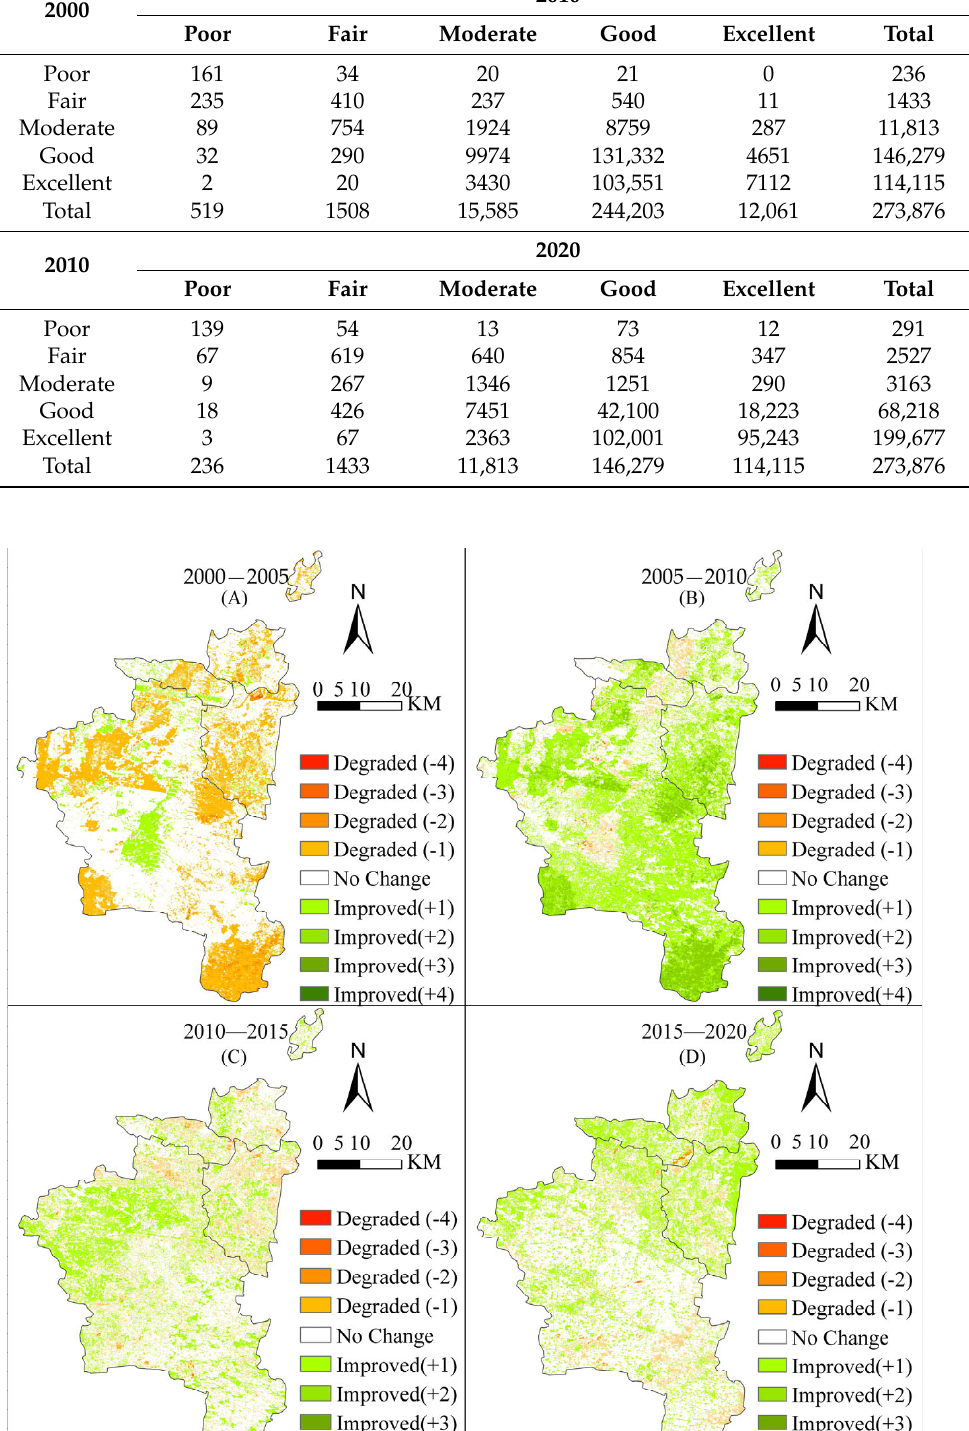
9618 km, accounting for 3.5%. From 2010 to 2020, the ecological quality grade of 112,999 km of land increased by 41.15%, and the ecological quality grade of 8.07% of the land decreased. Among them, the area converted from GE% to PFM% was 10,326 km, account ‐ ing for 3.76%, and the area converted from PFM% to GE% was 2827 km, accounting for 1.02%. Therefore, it can be concluded that the overall ecological environment quality of Huaibei City tends to be stable. 3.2. Analysis of Barycenter Migration To further understand the spatial change trend of ecological environment quality in Huaibei City, the barycenter migration model was used to calculate the barycenter coor ‐ dinates of different RSEI trends, and the barycenter migration diagram of the RSEI grade changes from 2000 to 2020 was drawn based on each barycenter position (Figure 7). From the perspective of the migration trajectory of RSEI grade changes from 2000 to 2020, the trajectory of the barycenter shows a similar pattern: the center of gravity first moves to the south and then moves to the northeast from 2005 to 2020. From 2000 to 2010, the bary ‐ center of the RSEI grade increased to the southeast, while the barycenter of the RSEI grade decreased to the opposite direction.